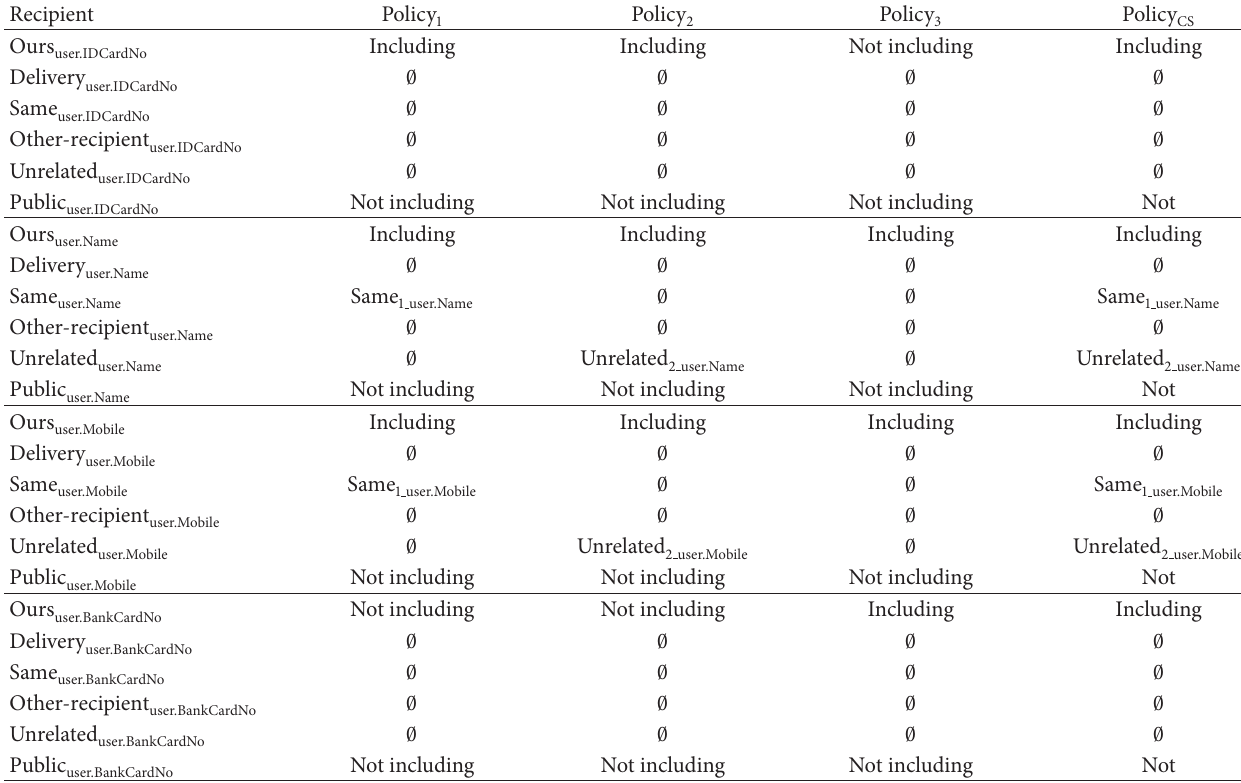
Algorithm 6: P3P privacy policy for Service A. Table 6: Recipient values of Data elements in TravelBroker.